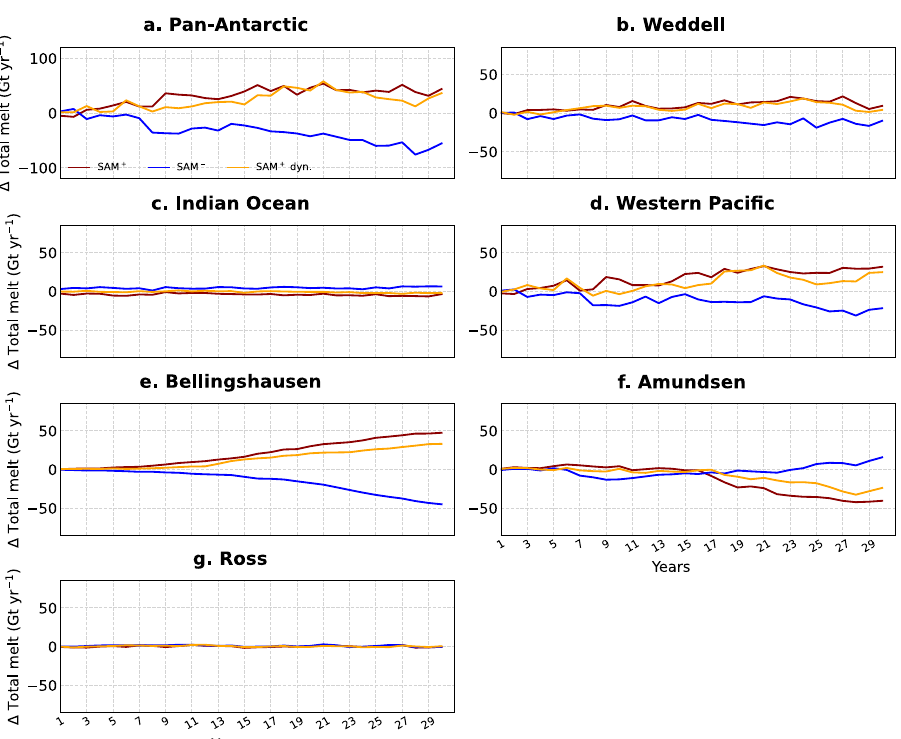
Fig. 2 Evolution of ice-shelf basal melt rate in response to the SAM perturbations. Time series of ( a ) pan-Antarctic and ( b – g ) regional ice-shelf basal melt rate change (in Gt yr − 1 ) between the SAM + run and the CTRL run (red line), the SAM − run and the CTRL run (blue line) and the SAM þ dyn run and the CTRL run (orange line). The x-axis represents year 1 through 30 of each simulation. The regions are de fi ned in Fig.